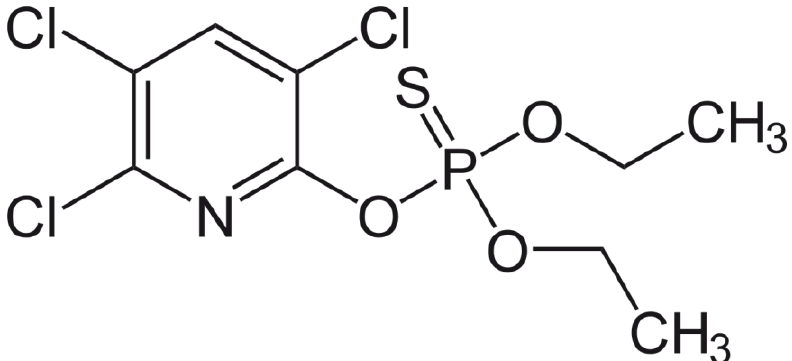
Figure 1. Chlorpyrifos ® structure. Its structure is representative of the class of organophosphate insecticides (phosphorothioates), but is a particularly insoluble organophosphate and has chlorine groups to limit and slow down biodegradation. It is a weak electrolyte.